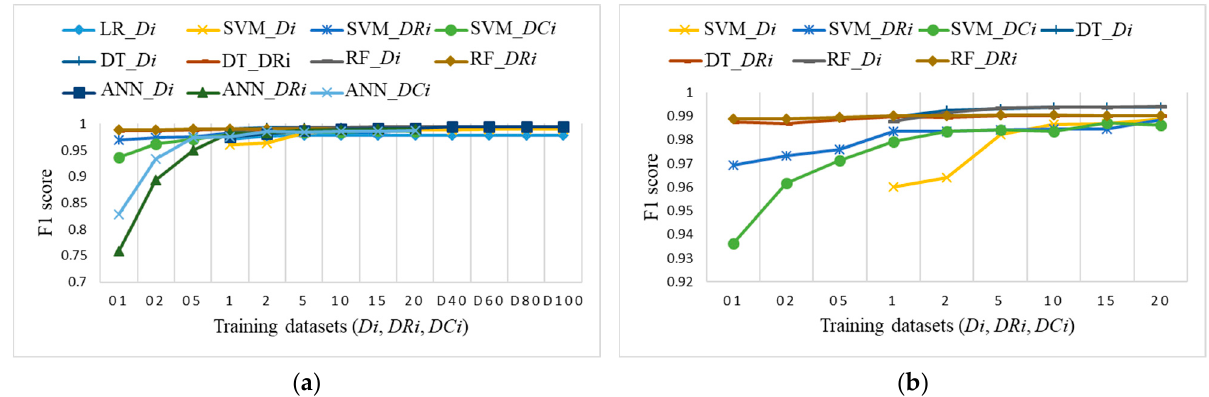
Figure 20. F1 score on test dataset for training datasets Di , DRi , and DCi : ( a ) ML algorithms for most of datasets, without